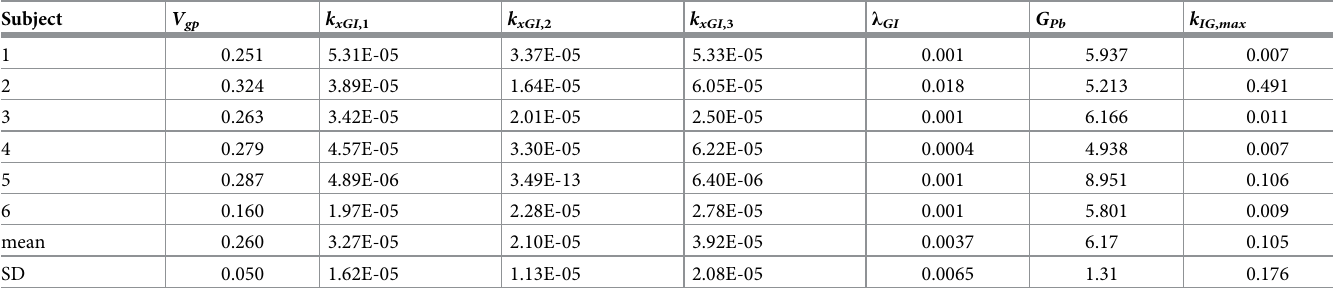
Table 5. Parameter estimates of the one-glucose compartment model.